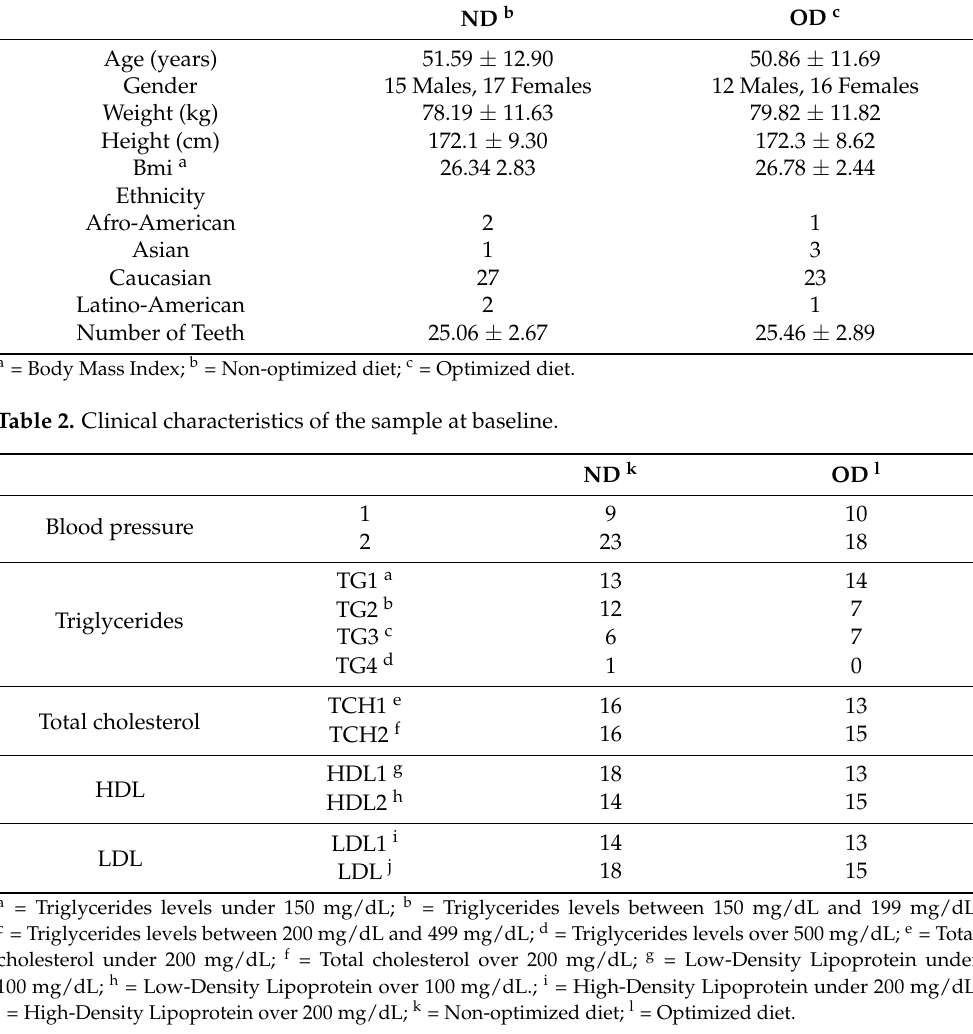
Table 1. The demographic characteristics of the sample.